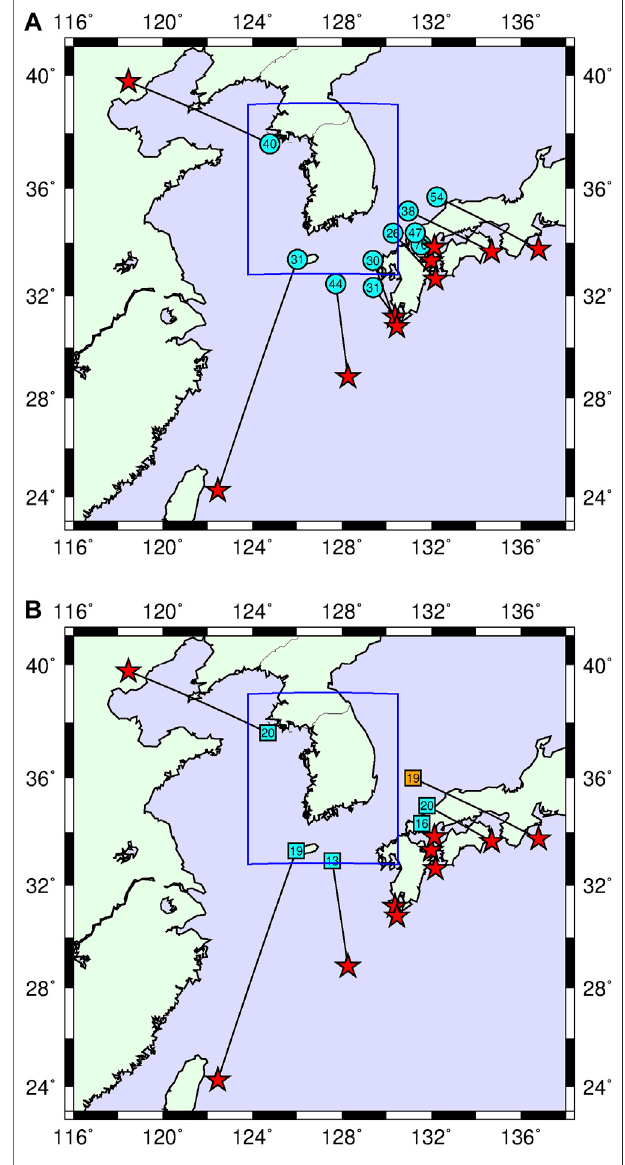
FIGURE 2 | Epicenters of regional earthquakes and associated results. Epicenters of the events associated by (A) binder_ew (circles) and (B) binder_max (squares). Red stars represent the epicenters located by the U.S. Geological Survey ’ s National Earthquake Information Center (NEIC) or the Japanese National Research Institute for Earth Science and Disaster Prevention(NIED).Numbersinsymbolsrepresent thenumber ofphases used for associations. An orange square indicates the events that were removed during the update procedure of the